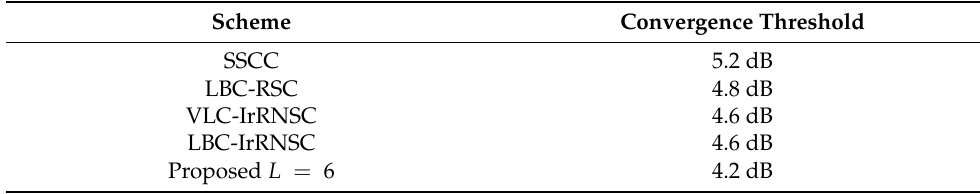
Table 5. Convergence performance of different source channel coding schemes.